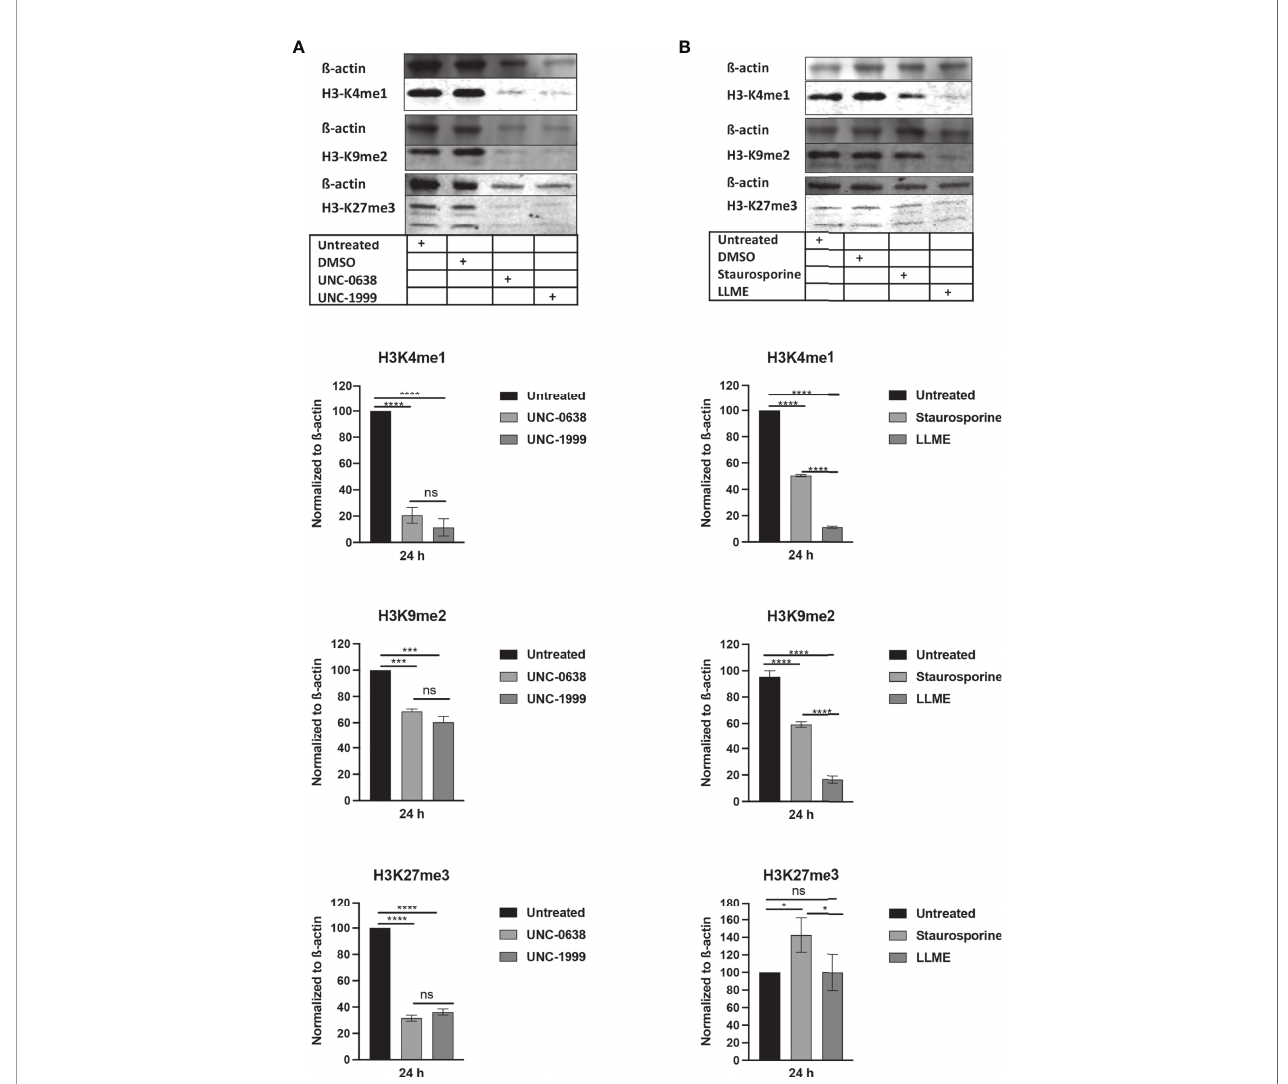
FIGURE 2 | Cytotoxic agents cause reductions in the levels of epigenetic histone marks in mast cell leukemia cells. HMC-1 cells (0.5 × 10 6 cells/ml) were incubated for 24 hours with (A) UNC-0638 (25 m M), UNC-1999 (50 m M), (B) staurosporine (1 m M) or H-Leu-Le (400 m M), followed by Western blot analysis for the levels of the H3K4me1, H3K9me2 and H3K27me3 marks, with ß-actin as loading control. Quanti fi cation of H3K4me1, H3K9me2 and H3K27me3 levels by densitometry is shown in the lower part of the panels. Data are representative of three independent experiments and are given as mean values ± SEM (n=3). *p ≤ 0.05; ***p ≤ 0.001; ****p ≤ 0.0001. ns, not signi fi